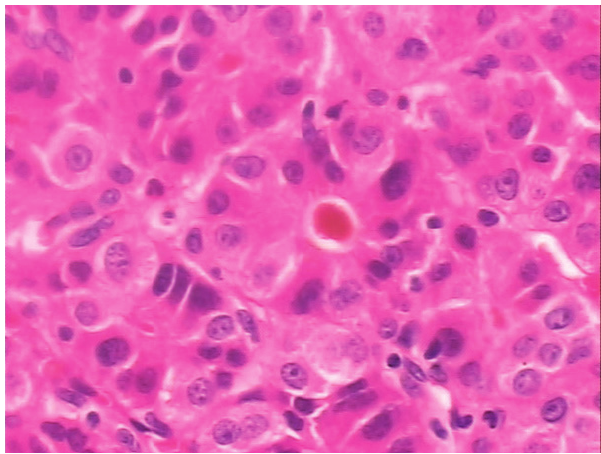
Figure 2, Panel A. Biopsy of orbital mass shows a neoplasm with pseudoglandular, trabecular pattern of polygonal cells, prominent nucleoli, vesicular nuclei, and bile plugs (hematoxylin and eosin staining; magnification,